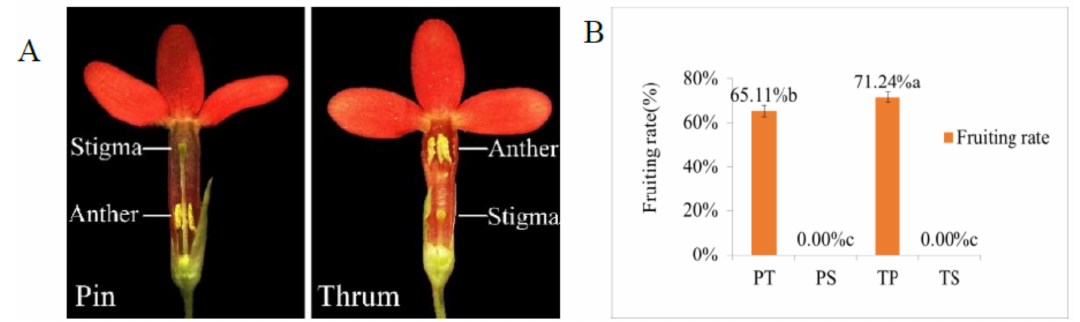
Figure 1. P. maximowiczii floral phenotypes and fruiting rates of different pollinations. ( A ) Pin flower with long style and thrum flower with short style; ( B ) Fruiting rates of different pollination treatments.